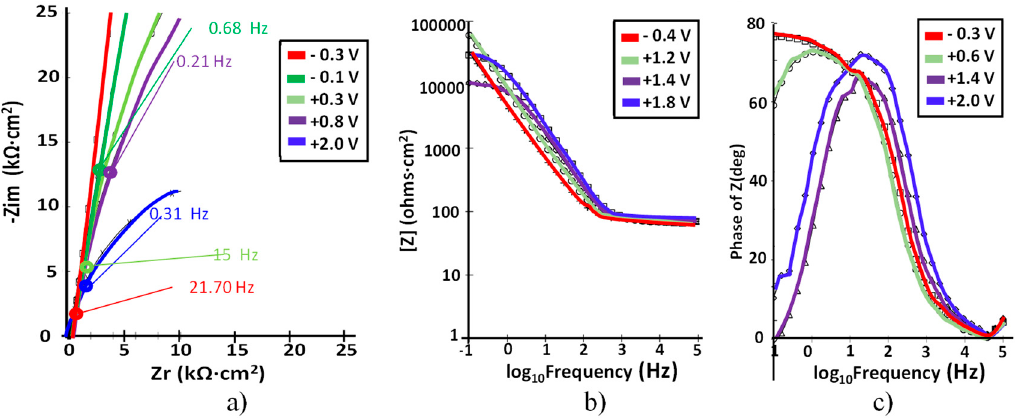
Figure 8. ( a ) Nyquist; ( b ) Bode –IZI and ( c ) Bode-phase spectra at different potentials for Ti–25Ta in simulated body fluid at pH = 7.8. Figure 7. ( a ) Nyquist; ( b ) Bode –IZI and ( c ) Bode-phase spectra at different potentials for Ti–15Ta in simulated body fluid at pH = 7.8.